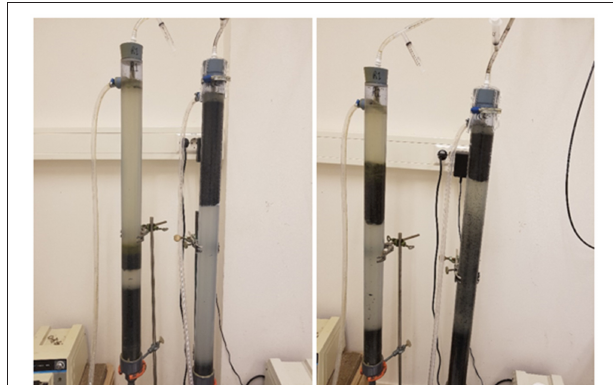
FIGURE 9 | Photograph of the floating granular sludge during the operation period.